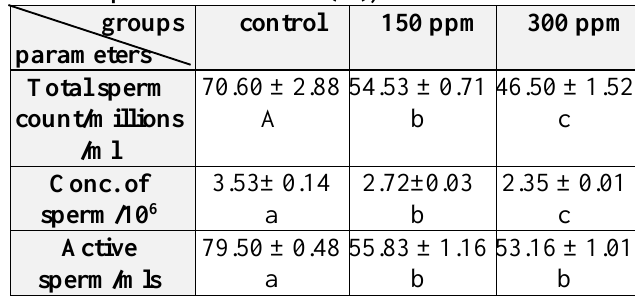
Table 3. Effects of different sub lethal concentrations of sodium fluoride given with drinking water on various sperm characteristic (%), mean ± SE.